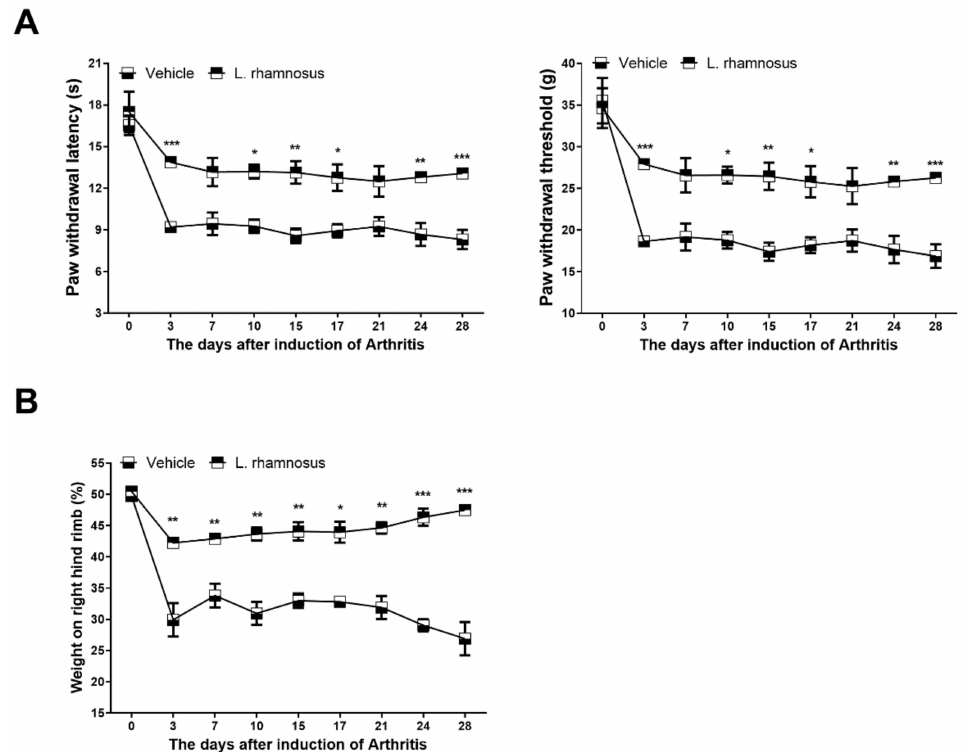
Figure 1. L. rhamnosus (LR-2) showed a therapeutic effect in OA rats. ( A ) Pain behavior was analyzed as PWL (left) and PWT (right) in vehicle-treated MIA-induced OA rats, and L. rhamnosus (LR-2)-treated MIA-induced OA rats ( n = 6 per group) until day 28. ( B ) Weight bearing was examined in all groups ( n = 6 per group) until day 28. Data are presented as the mean ± SD of three independent experiments. * p < 0.05, ** p < 0.01, and *** p < 0.001.